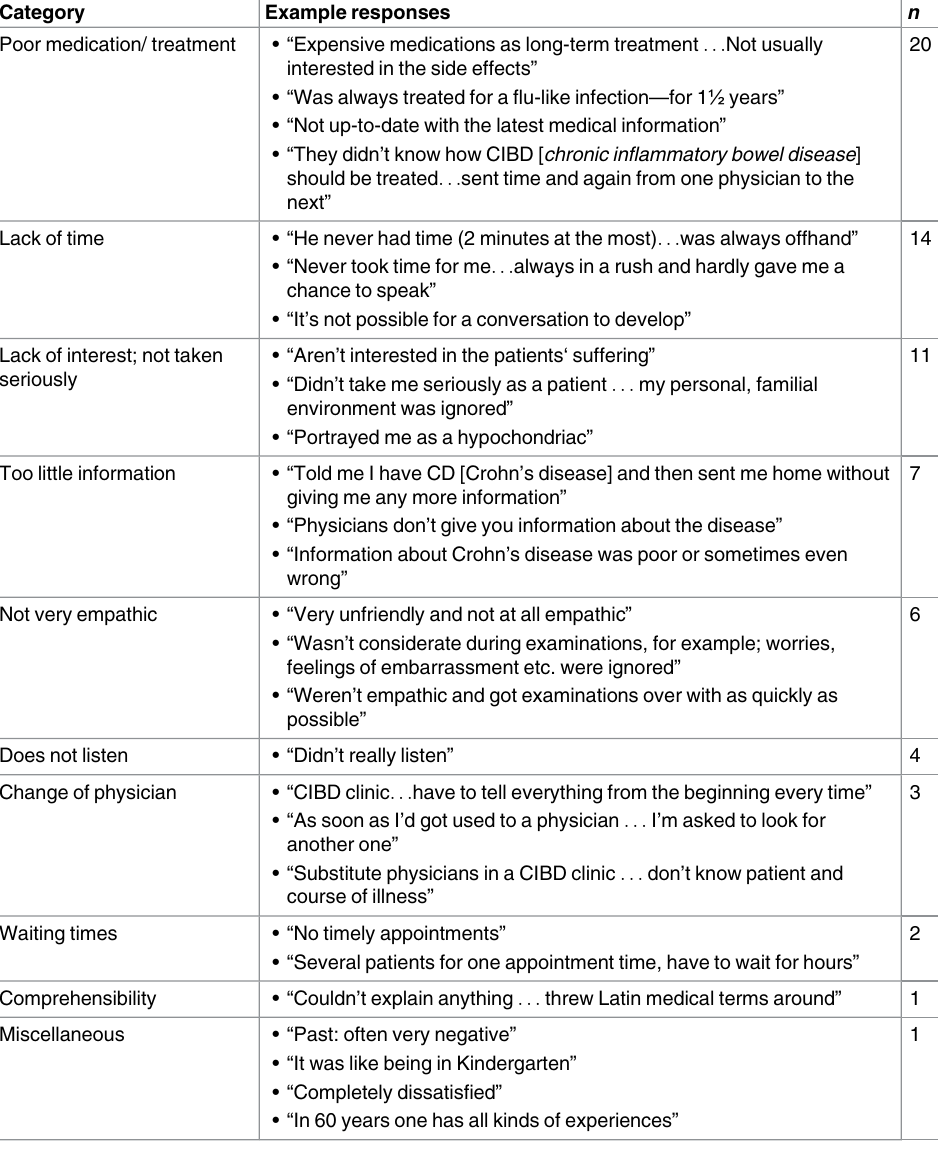
Table 2. Free-text responses to questions about patients’ perceptions of previous negative experi- ences with physicians (translated into English by the authors).